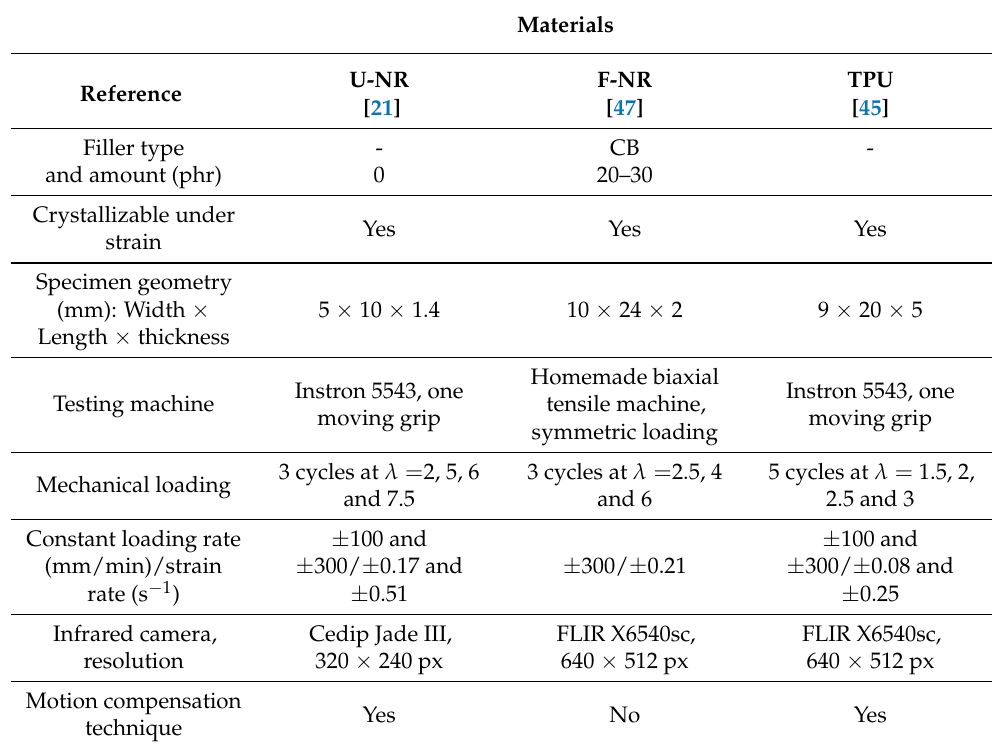
Figure 1. Typical experimental setup: the specimen is stretched symmetrically with a home-made biaxial testing machine, the temperature field is measured with an infrared camera. Table 2. Summary of the experiments